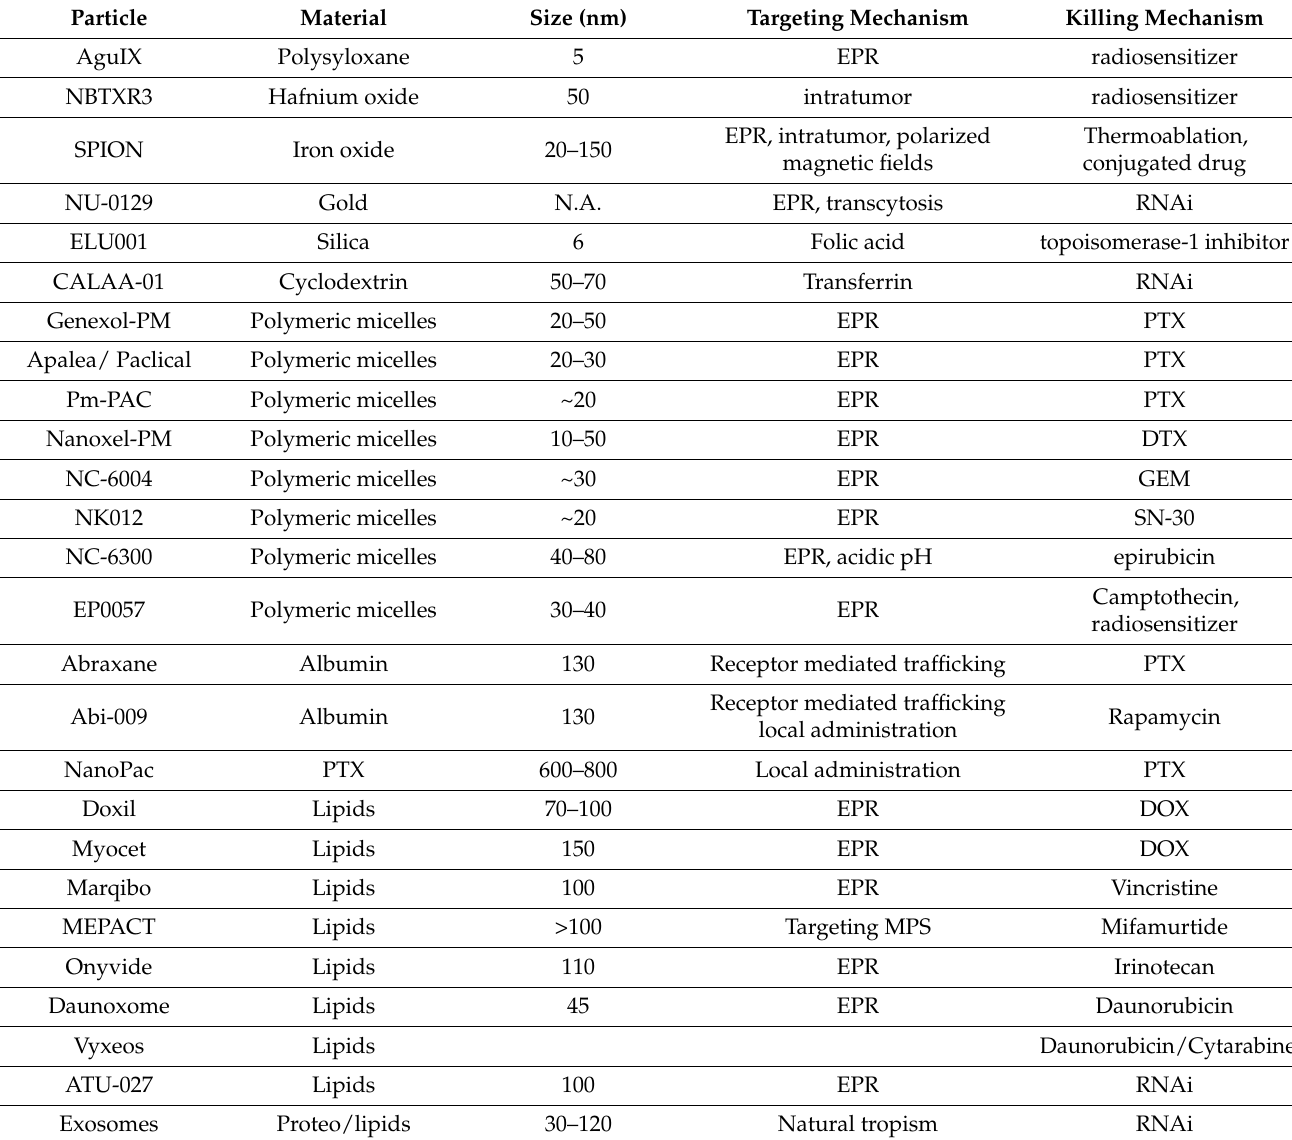
Table 1. Characteristics and targeting mechanism of nanocarriers in clinical